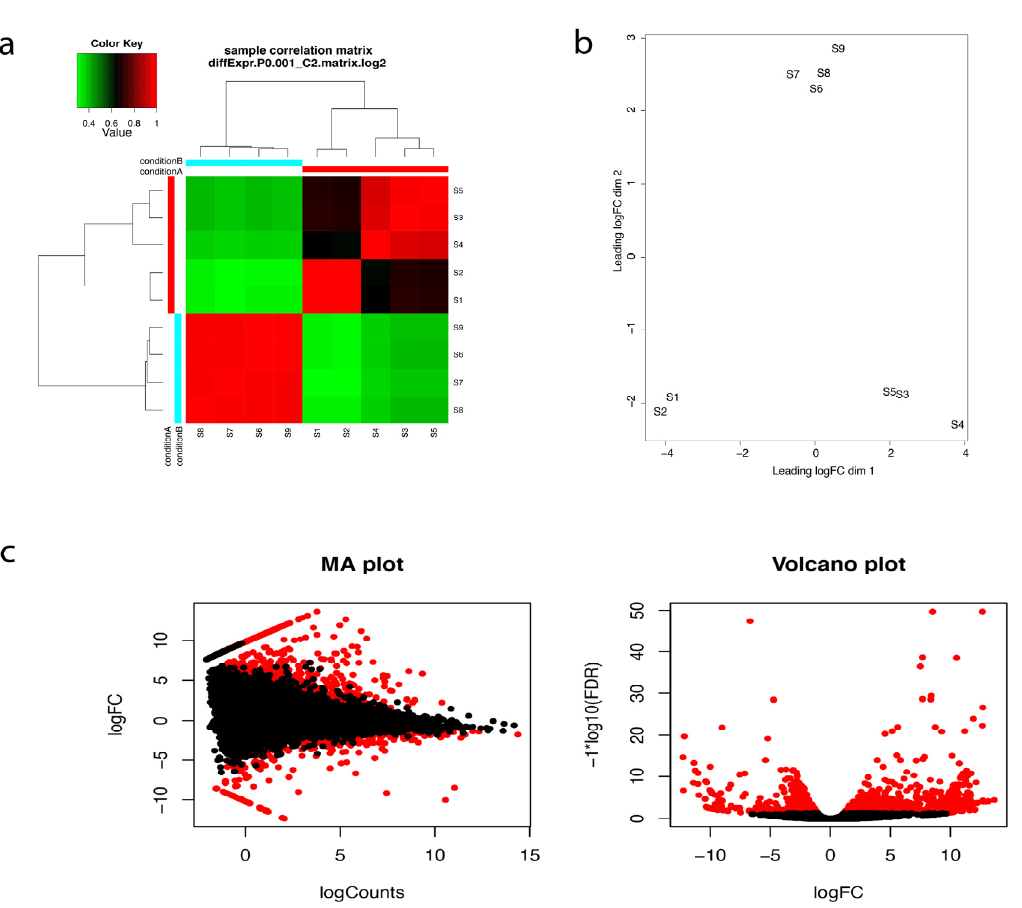
Figure 3. ( a ) Correlation matrix showing relationship between all samples as well as replicates. S1–S5 are the five replicates from the oceanside and S6–S9 are the four replicates from the riverside. Condition A and Condition B refer to the Oceanside and the Riverside respectively ( b ) Principal component analysis and ( c ) Pairwise comparisons of transcript abundance. MA plots showing average log fold change (logFC) vs. average log of counts among oceanside vs. riverside transcripts, across replicates. Volcano plots showing differentially expressed transcripts in relation to FDR (False discovery rate) for oceanside vs. riverside transcripts. Features found DE at FDR < 0.05 are coloured red. Features with p -values at most 1 × 10 − 3 and at least 2 2 -fold change are differentially expressed.